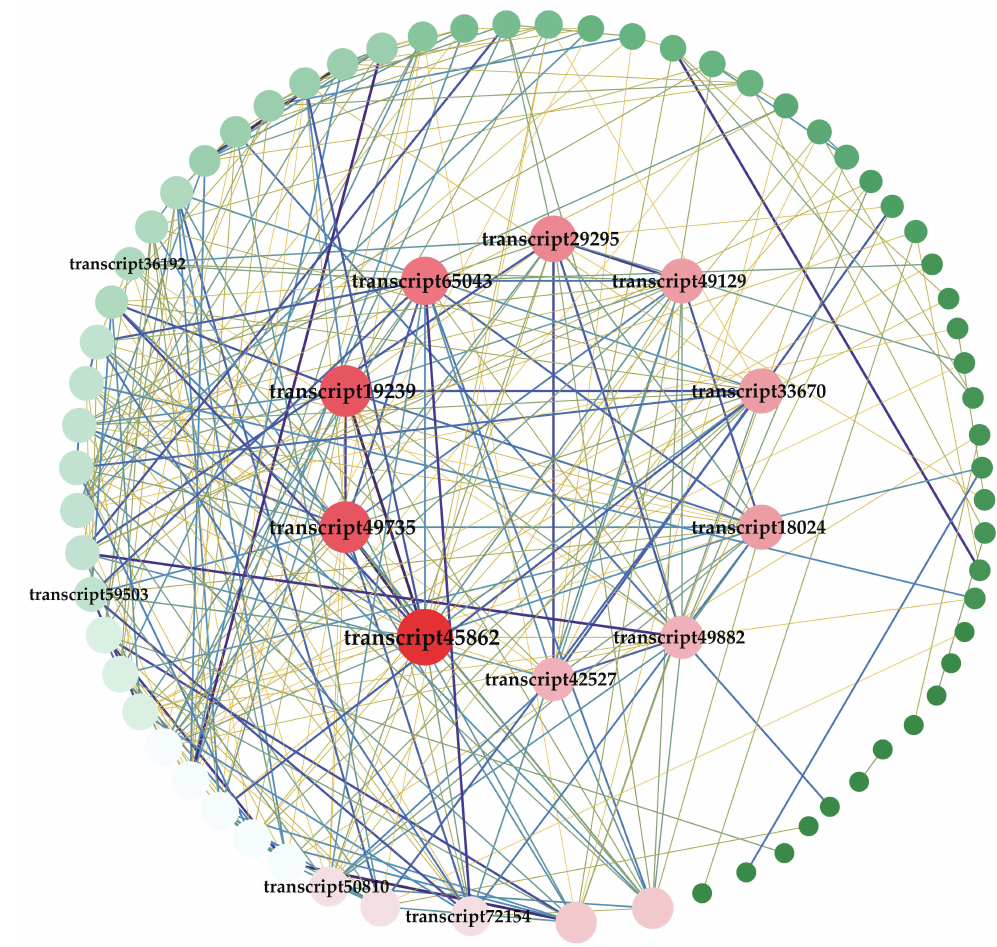
Figure 6. Co-expression analysis in module green of A. gymnandrum. Transcript 45862, transcript 49735, transcript 49882, transcript 19239, transcript 65043, transcript 42527, transcript 29295, transcript 33670, and transcript 49129 were filtered as hub genes by degree. The circle depicts genes co-expressed with 10 hub genes (r > 0.8; 77 genes in total). The size and color (red to green) of the circle were arranged according to the degree, and the lines indicate the p -value between the genes (purple is the largest and yellow is the